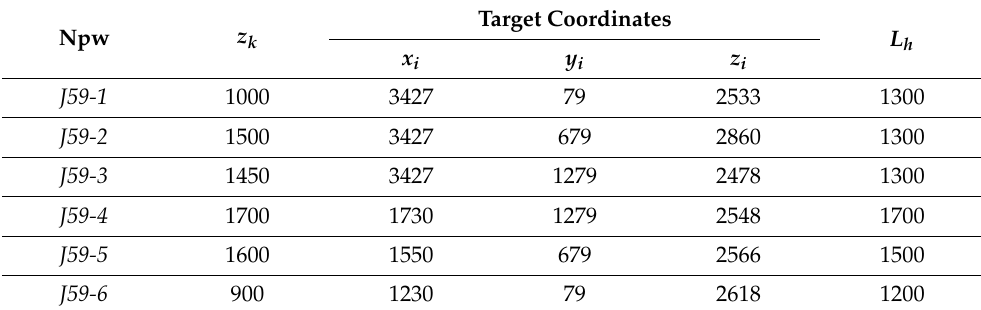
Table 3. The drilling design of the J59 well group.